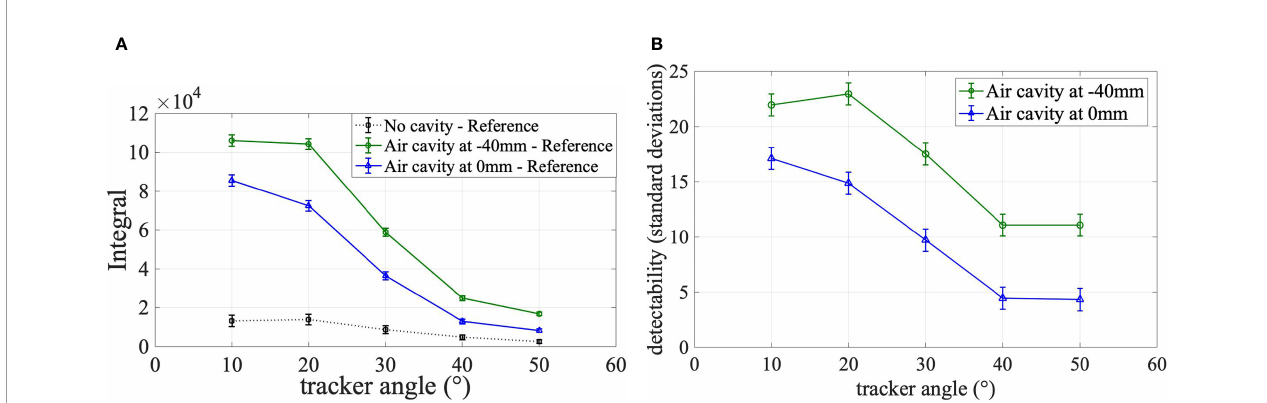
FIGURE 6 | (A) Integral of absolute differences, (B) Detectability. (A) Integral of the absolute difference between secondary-ion emission pro fi les of the reference fraction and the three follow-up fractions over the target area shown for all investigated mini-tracker positions. The integral of the difference between the reference fraction and the fraction without cavity is plotted as square black markers. The integral values between the reference fraction and the fraction with a cavity in front of the tumor volume are plotted as green circles. The integral between the reference fraction and the fraction with a cavity in the middle of the tumor volume is shown as blue triangles. (B) Detectability of the air cavity in units of combined standard